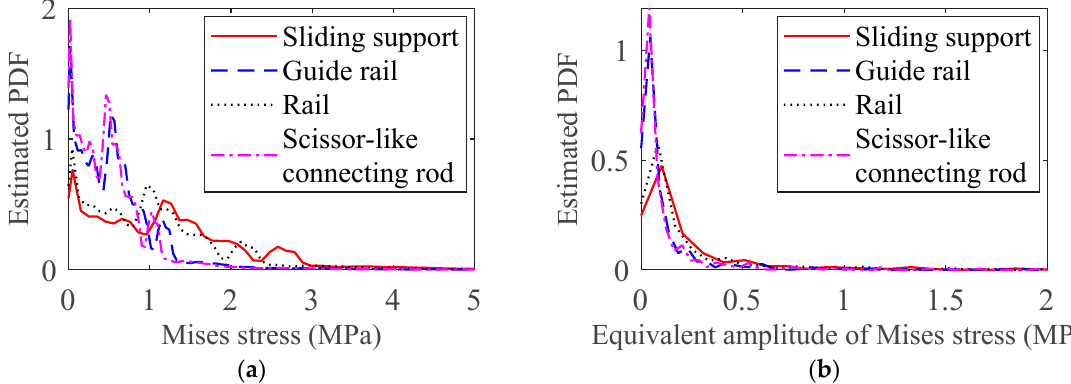
Figure 13. Kernel probability density function (PDF) of the von Mises stresses belonging to the calculated maximum points of the expansion device members: ( a ) data-driven calculated results; ( b ) rainflow equivalent amplitude.